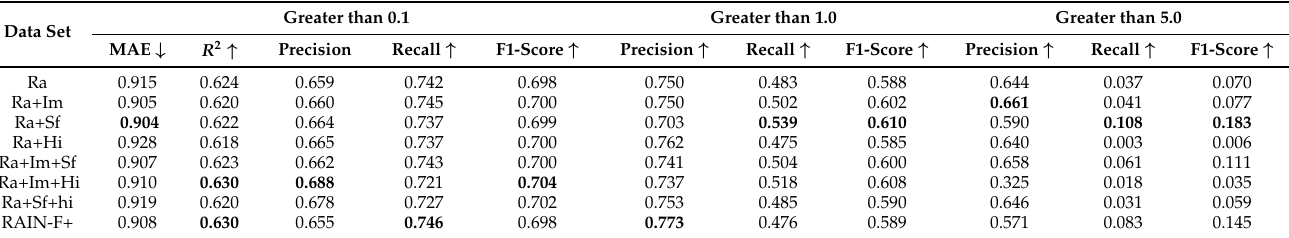
Table 3. Evaluation results for precipitation prediction in next one hour with the resolution of 32 × 32. Greater than 0.1 Greater than 1.0 Greater than Data Set